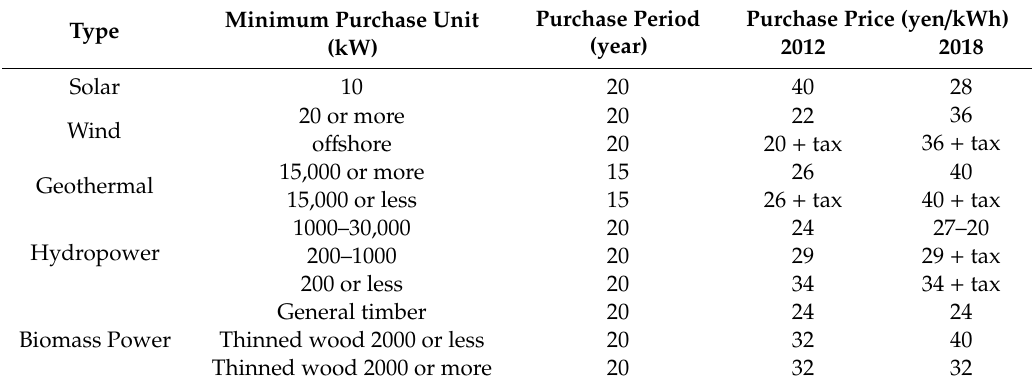
Table 1. Electricity purchase price by the feed-in tari ff (FIT) system (source: Ministry of Economy, Trade and